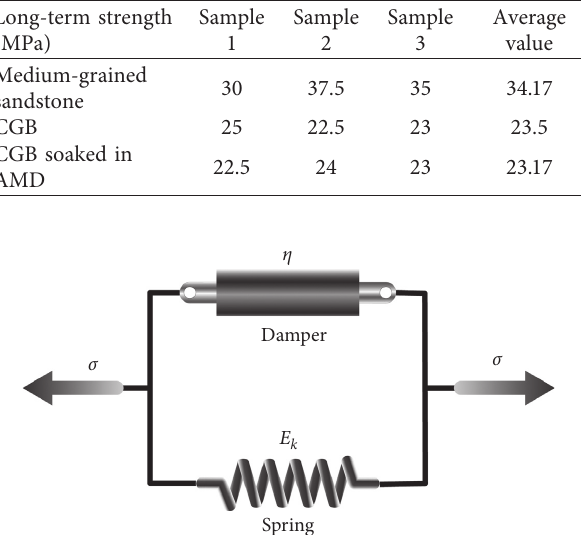
Figure 6: Illustration of the Kelvin model.